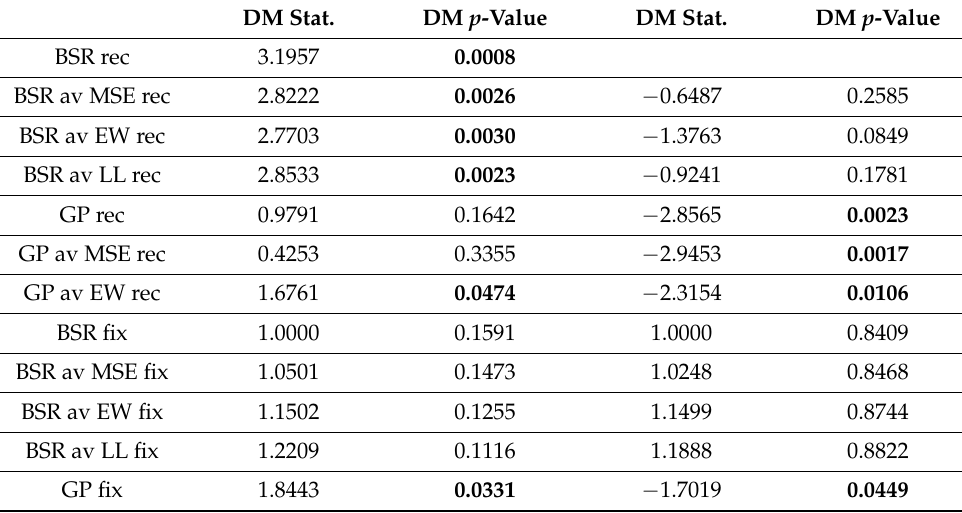
Table 6. Results of the Diebold–Mariano